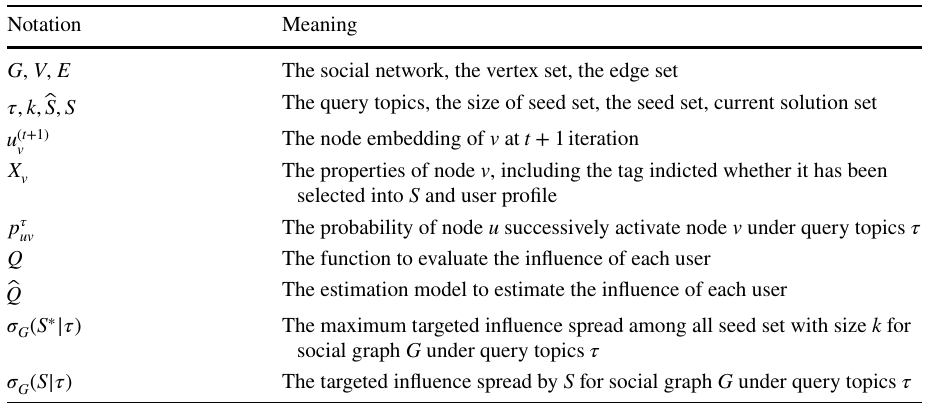
Table 1 Frequent notations used across the